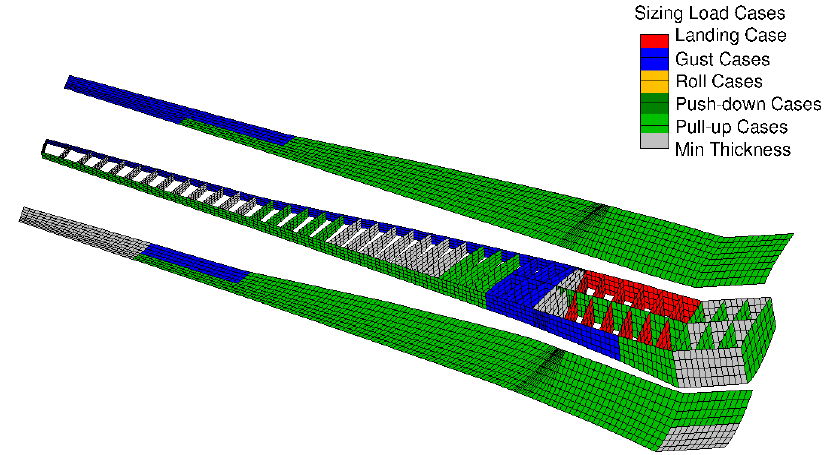
Figure 23. Sizing load cases for each design field—passive variant.